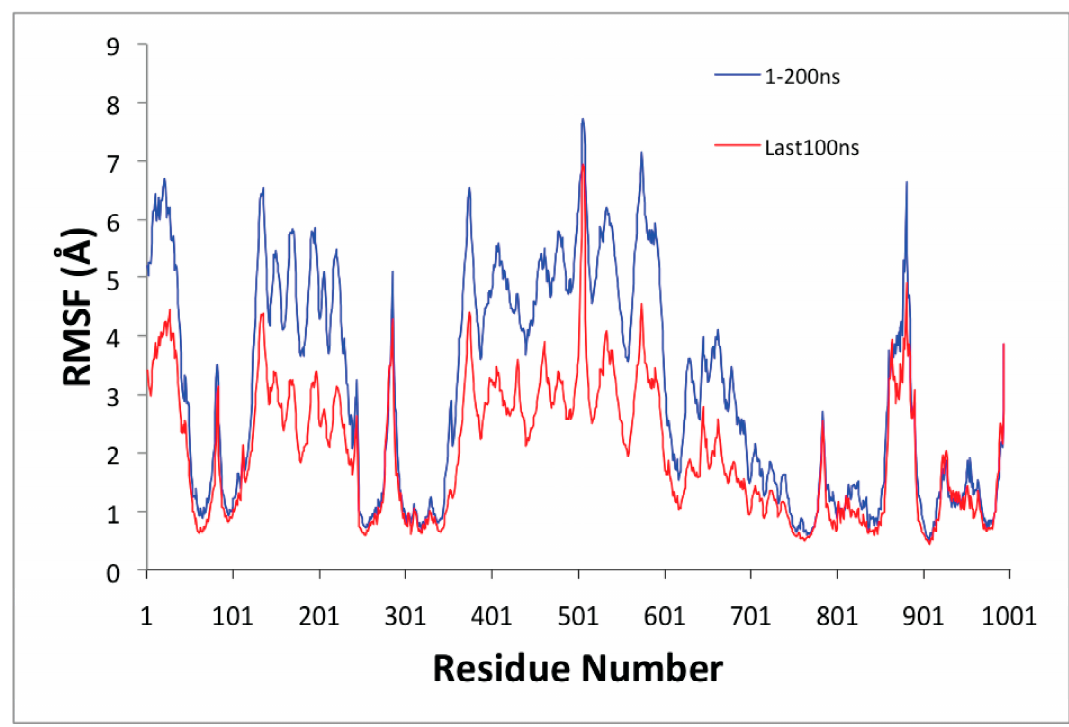
Figure 4. Root–mean–squared fluctuations (RMSF) values collected from the starting structure during the whole (blue) and the last 100 ns (red) molecular dynamics (MD) simulation.